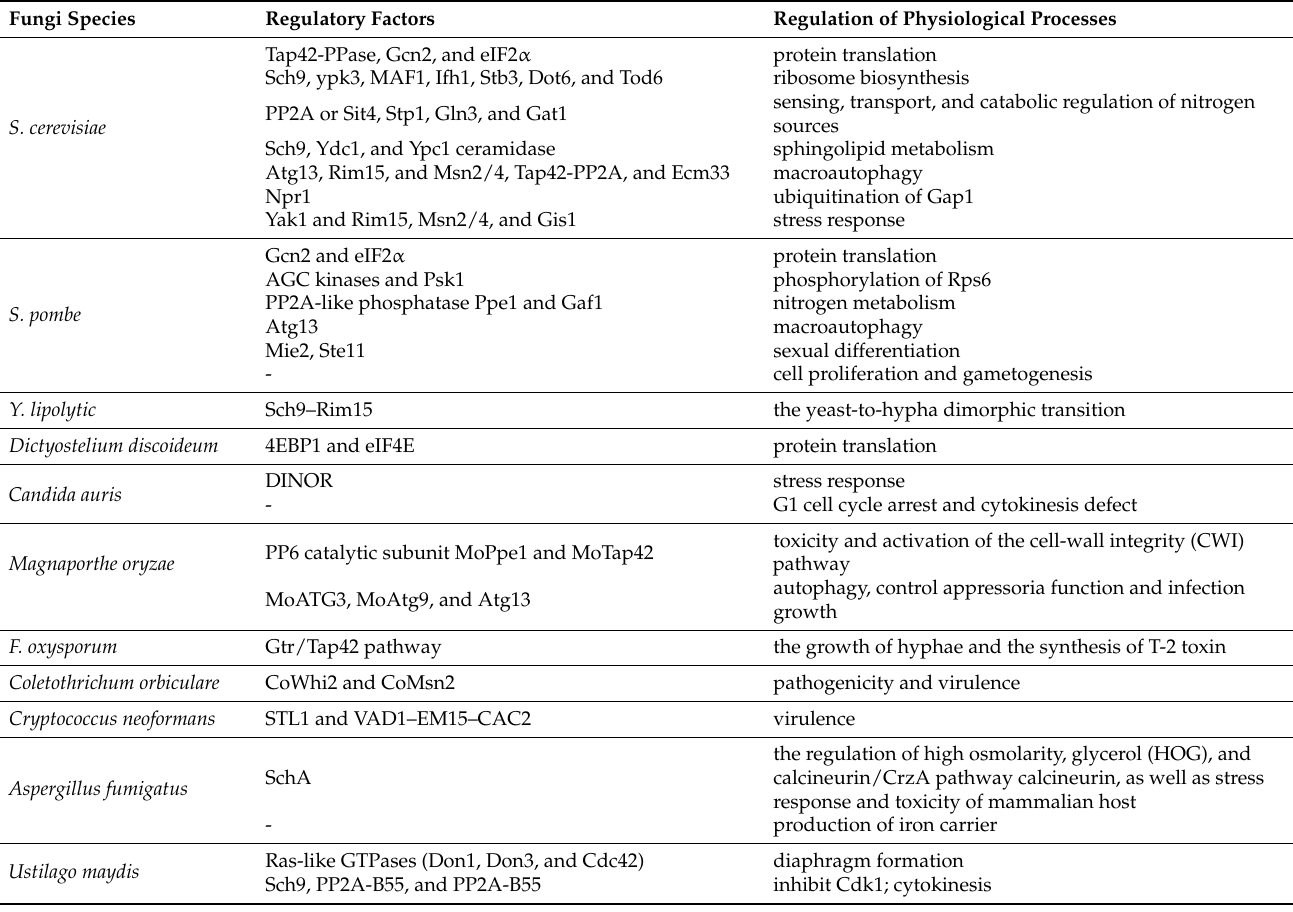
Table 2. TORC1 regulates physiological cell processes via regulatory